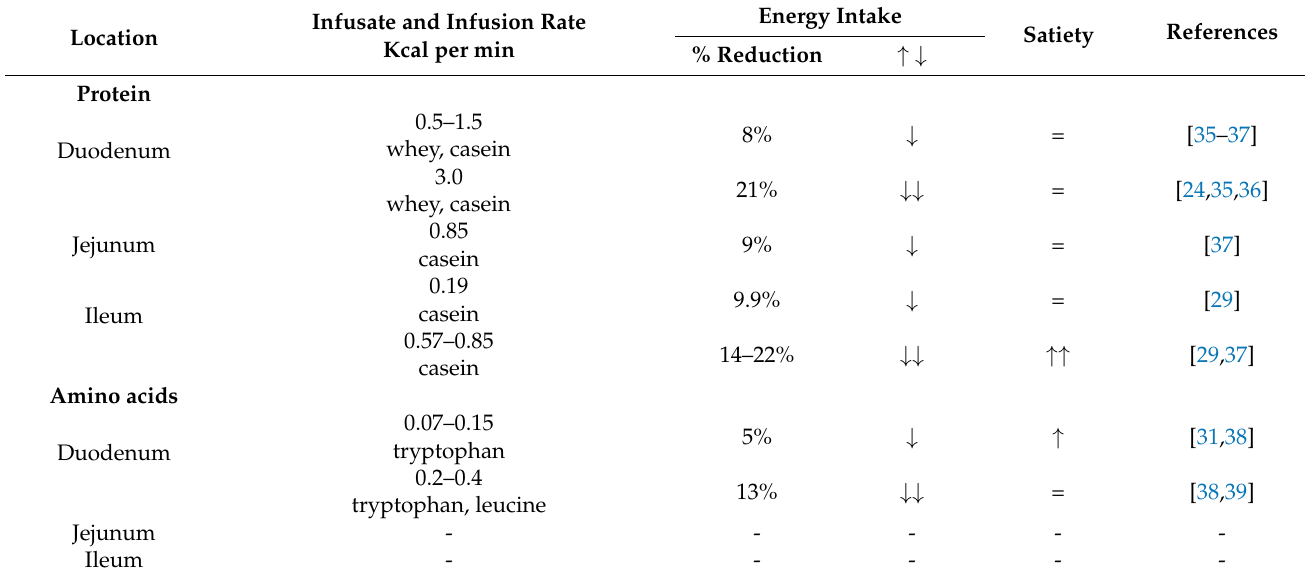
Table 2. Effect of infusion of protein or amino acids into duodenum, jejunum or ileum on energy intake and satiety.